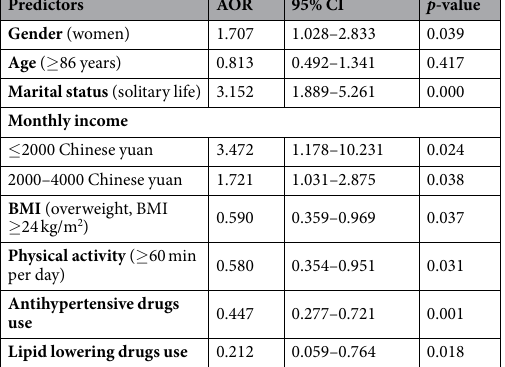
The associations between risk factors and cognitive impairment were further presented using the MCA plot (Fig. 2). In the MCA plot, the associations are interpreted based on the distance between two variables in the same quadrant: when two variables appear in the similar direction from centroid, the closer distance suggested a more likely association 22 . As shown in Fig. 2, gender, BMI, antihypertensive and lipid lowering drugs were more likely to be associated with cognitive function in this Chinese elderly population. In contrast, age, marriage, monthly income, and daily physical activity were less likely to predict cognitive function. The MCA plot is a statistically descriptive technique and was applied as a supplement for regression analysis in this study. Transformed domain-specific MMSE scores stratified by gender and the diagnosis of cognitive impairment were presented in Fig. 3. In this elderly Chinese population, MMSE scores appeared to be obviously lowest in the cognitive domains of attention and calculation (49.3%), as well as recall (39.7%). This disparity remained when assessing women and men separately. Moreover, domain-specific MMSE scores were consistently lower among elders with cognitive impairment than among those with normal cognition; however, the differences in MMES scores were remarkably large in the attention and calculation domain (66.5% vs. 9.0%), as well as recall domain (52.7% vs. 9.3%).